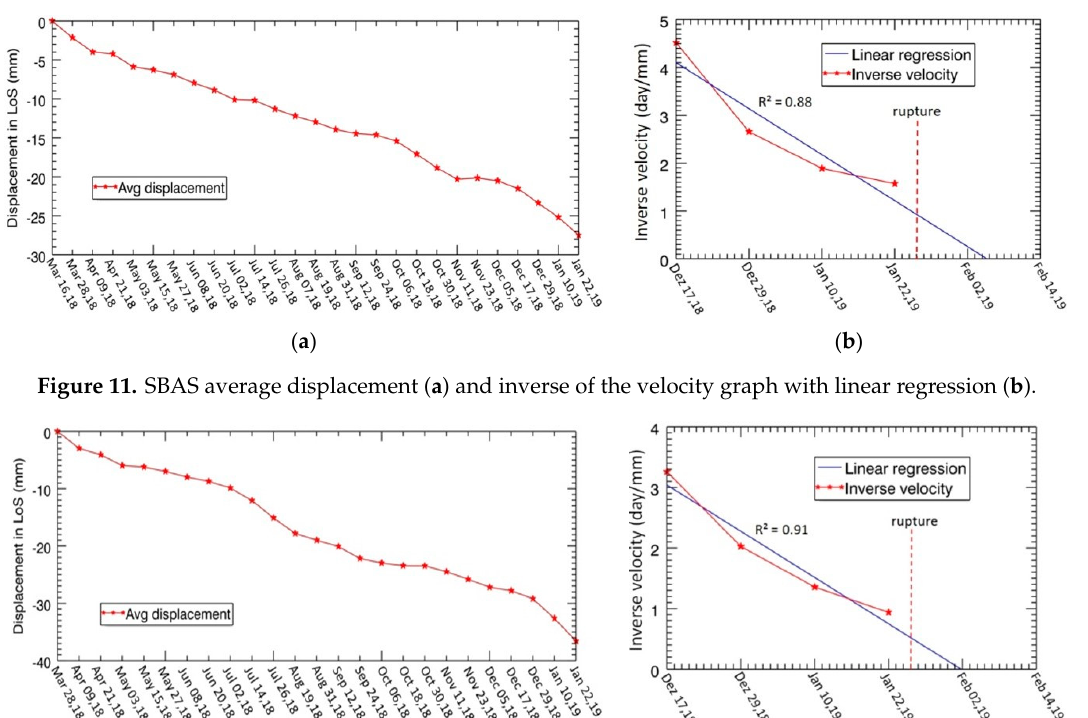
Figure 13. SBAS relative frequency distribution of the errors ( a ) and R 2 coefficient from the inverse velocity predictions ( b ).